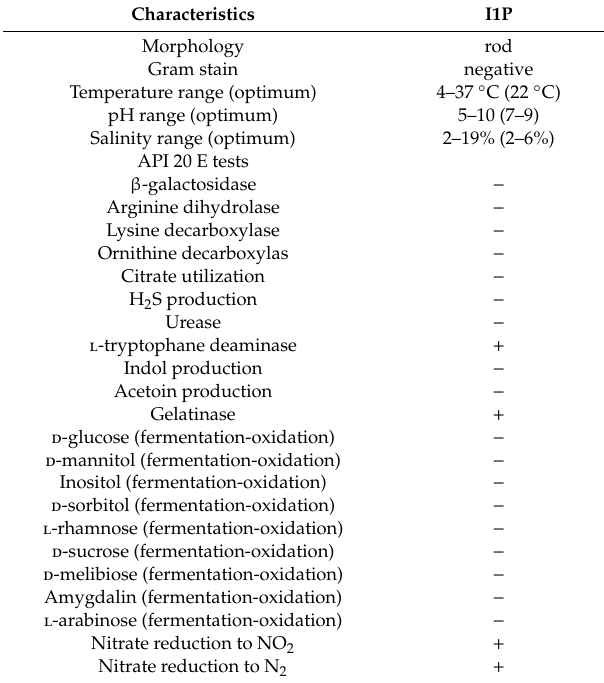
Table 1. Morphological, physiological, and biochemical characterization of strain